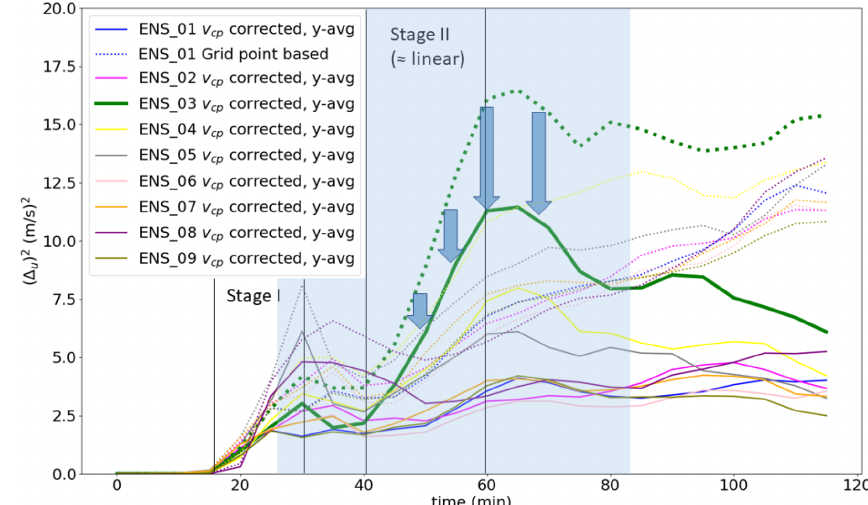
Figure 11. Error growth as measured by the ensemble variance in u , where each other member paired with the reference simulation. Both cold pool edge location corrected curves (solid lines) and grid-point-based comparisons (dotted lines) are displayed. Growth stages discussed in the text are also annotated in the figure (see text), and the key interval discussed in the analysis is highlighted by blue